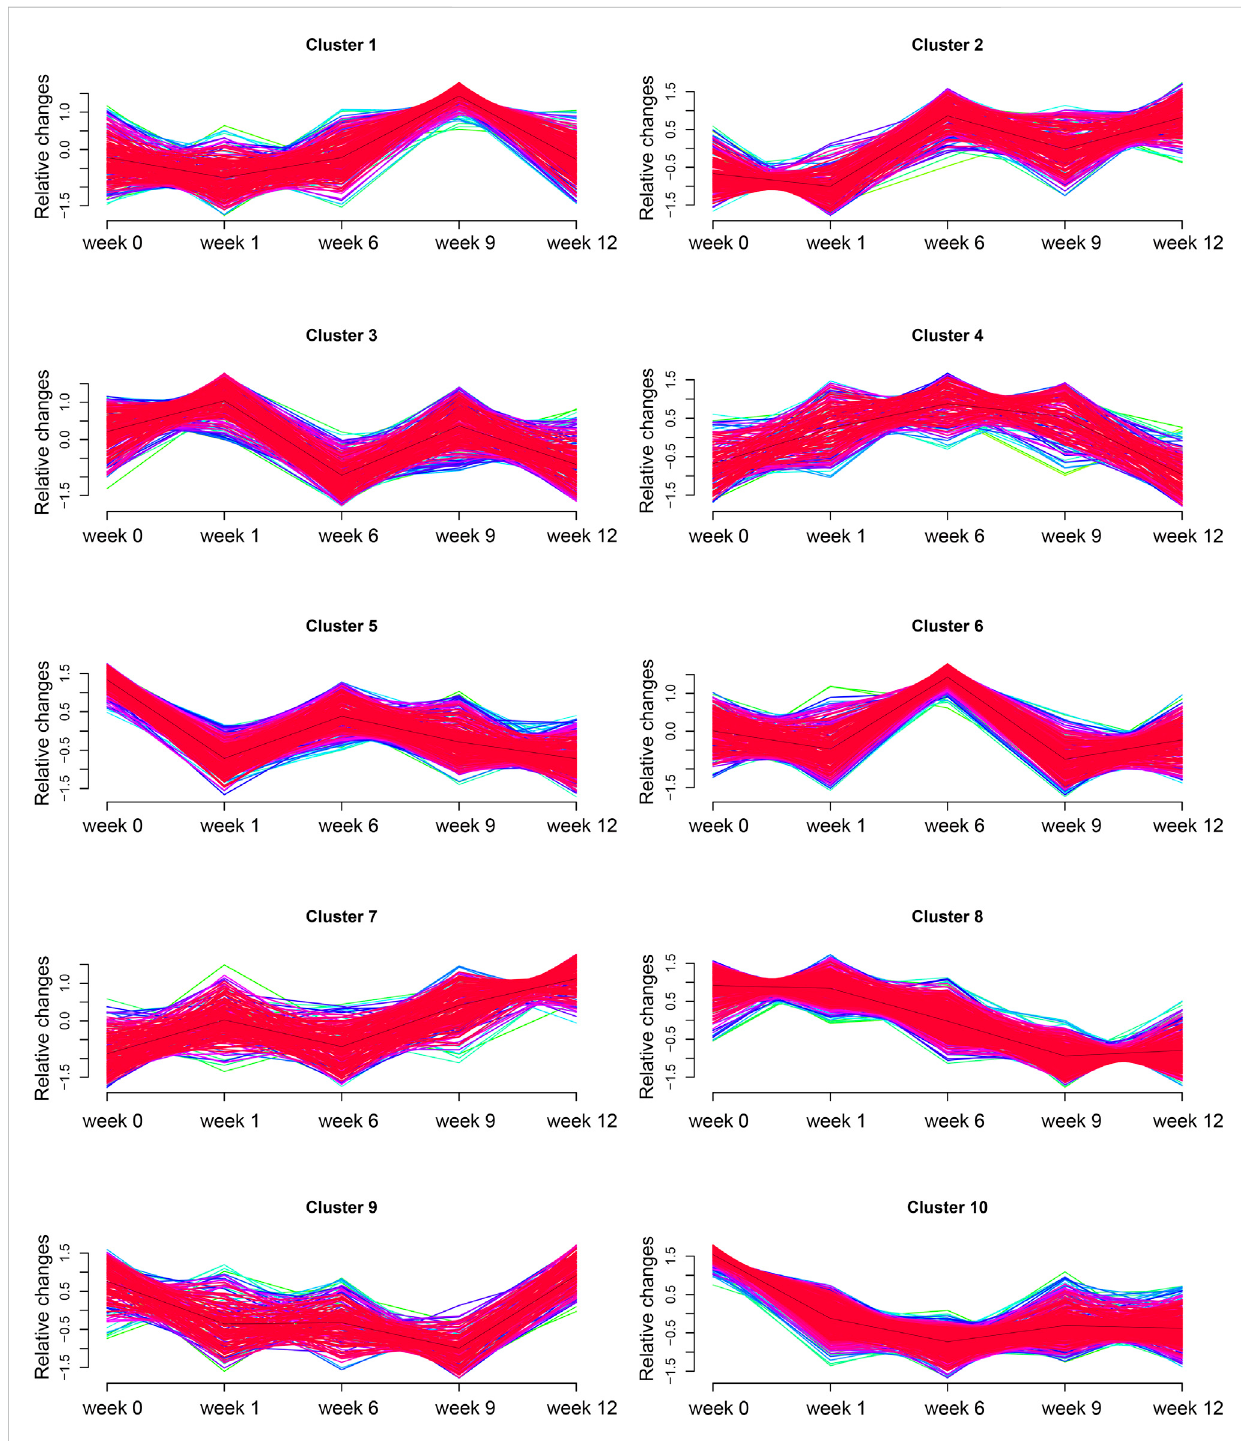
Time-series analysis. Ten clusters of metabolites with time-dependent metabolic pattern